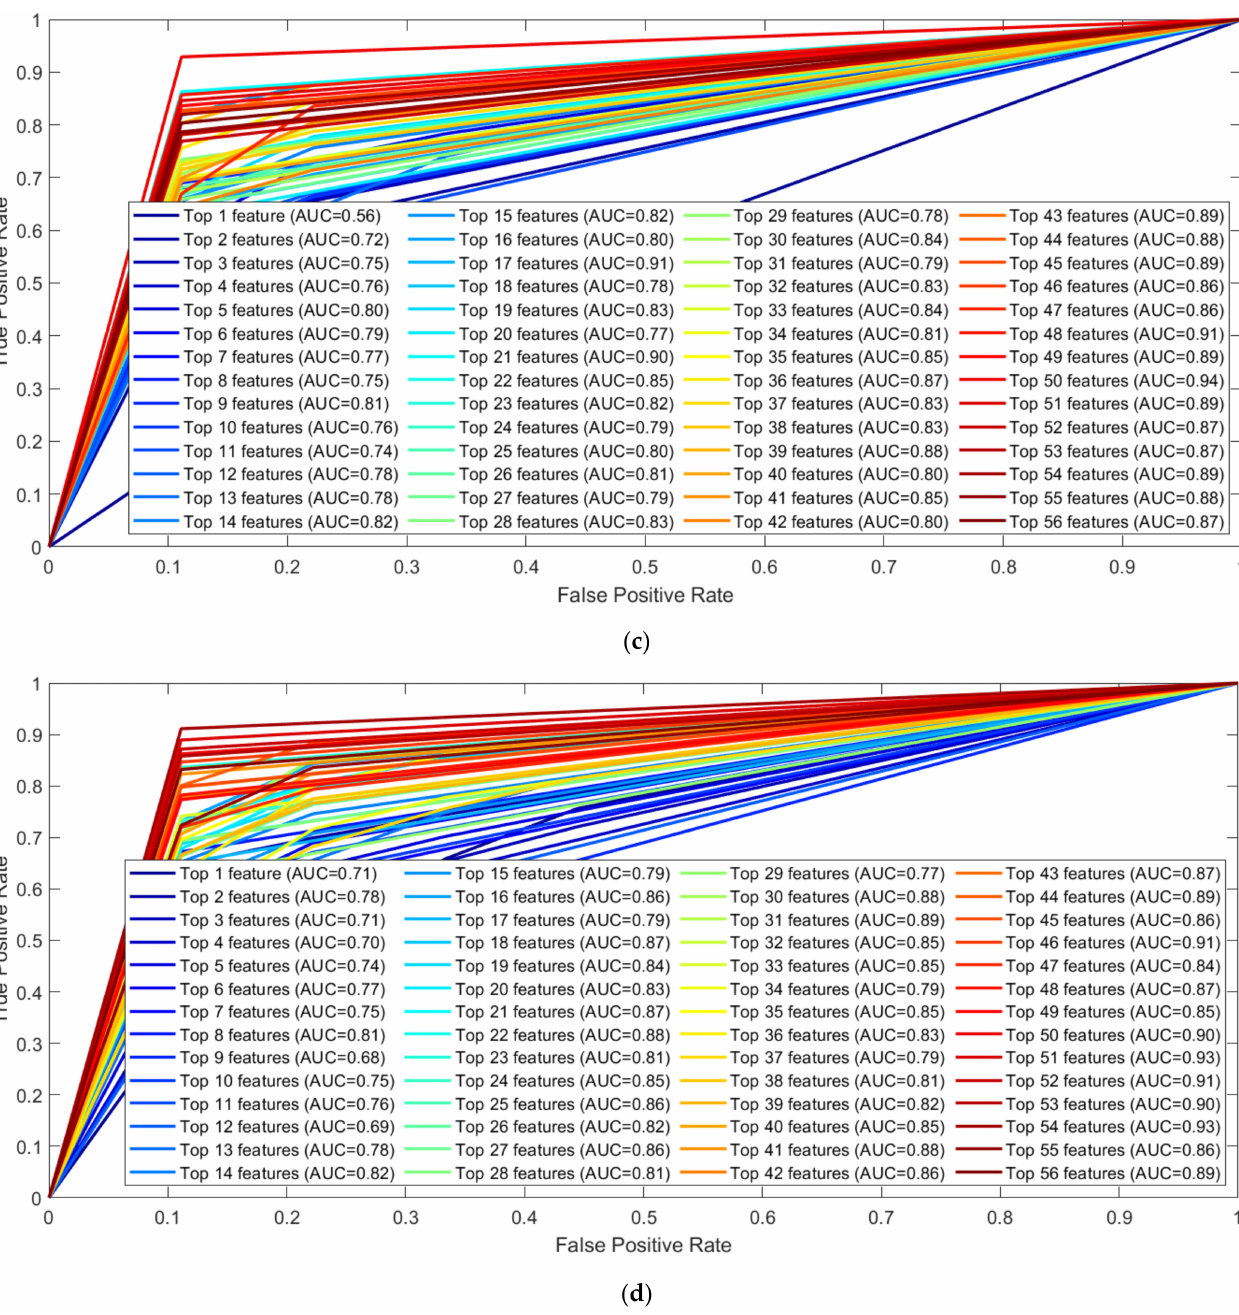
Figure 9. ROC curve for top-ranked features from the GRFx signal by ( a ) Chi-Square, ( b ) mrmr, ( c ) Relieff, ( d ) fscnca feature selection